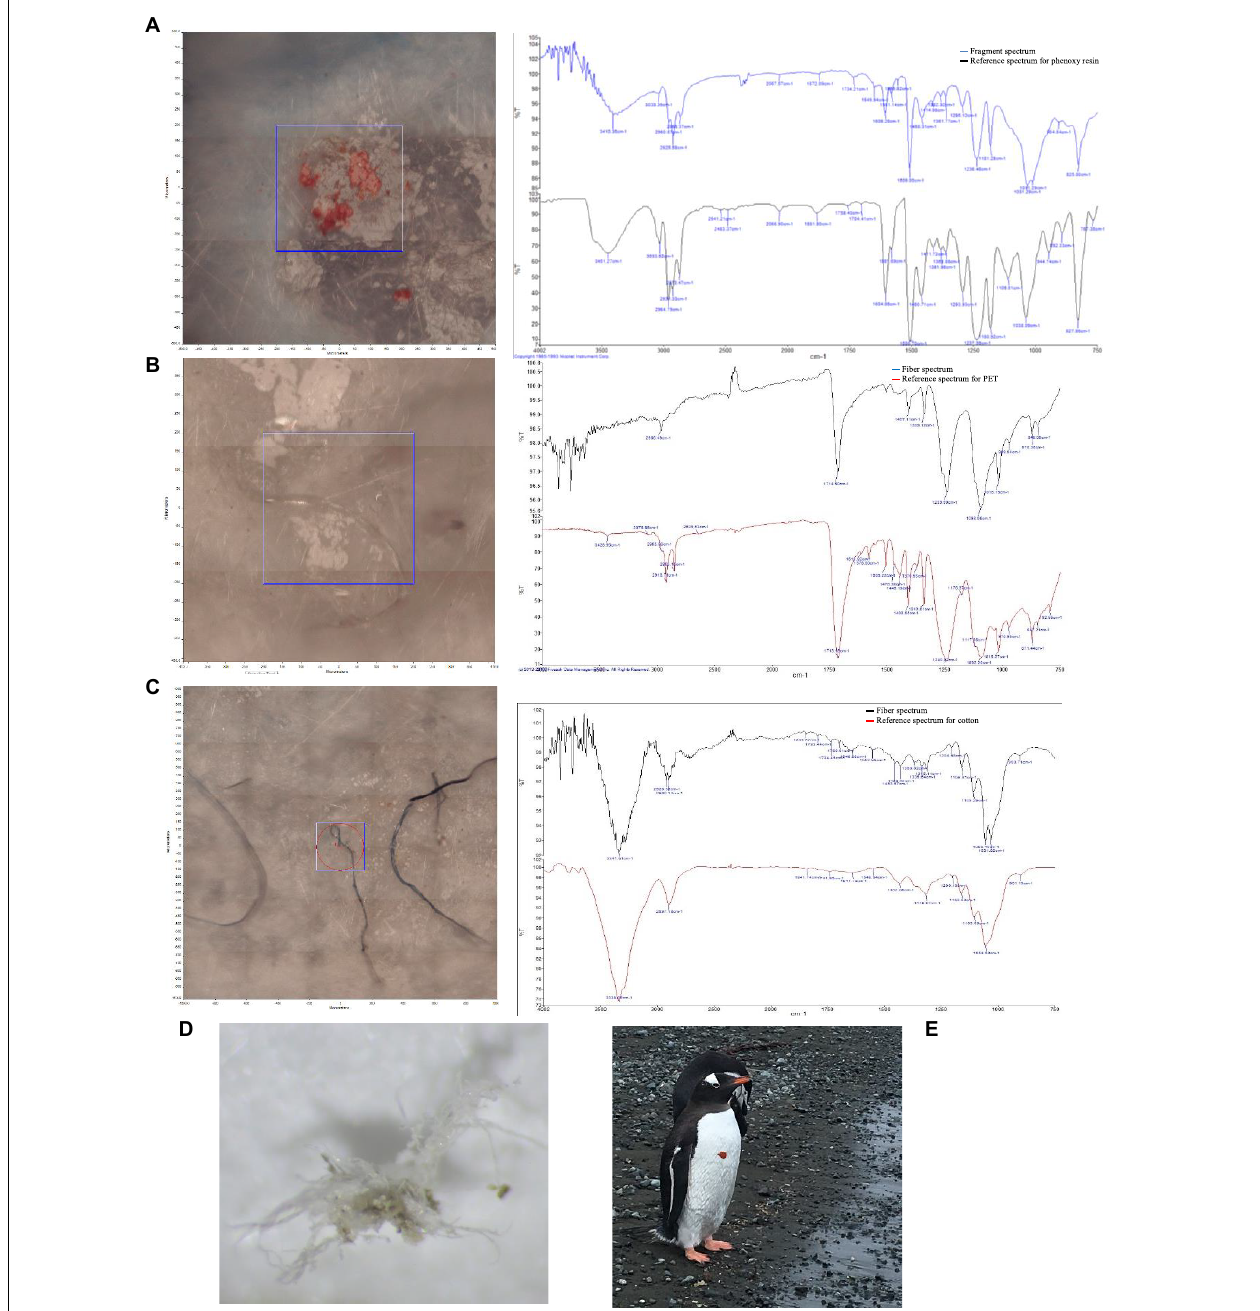
FIGURE 3 | Photograph and spectrum of an orange tree fragment of phenoxy resin (A) collected in soils, PET fiber (B) , cotton fiber (C) and a fiber found at the site IS6 (D) from intertidal sediments and a mesoplastic piece on P. papua (E) in Fildes Bay, Antarctica.